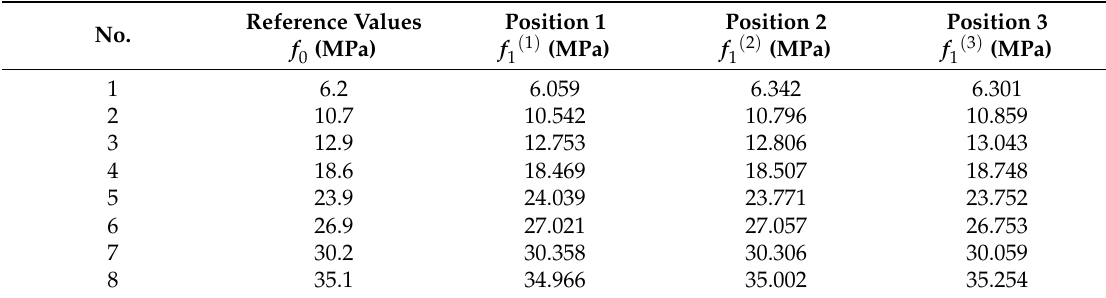
Table 4. Comparison of the results of readings measured by conventional methods in the meter image taken from three angles.